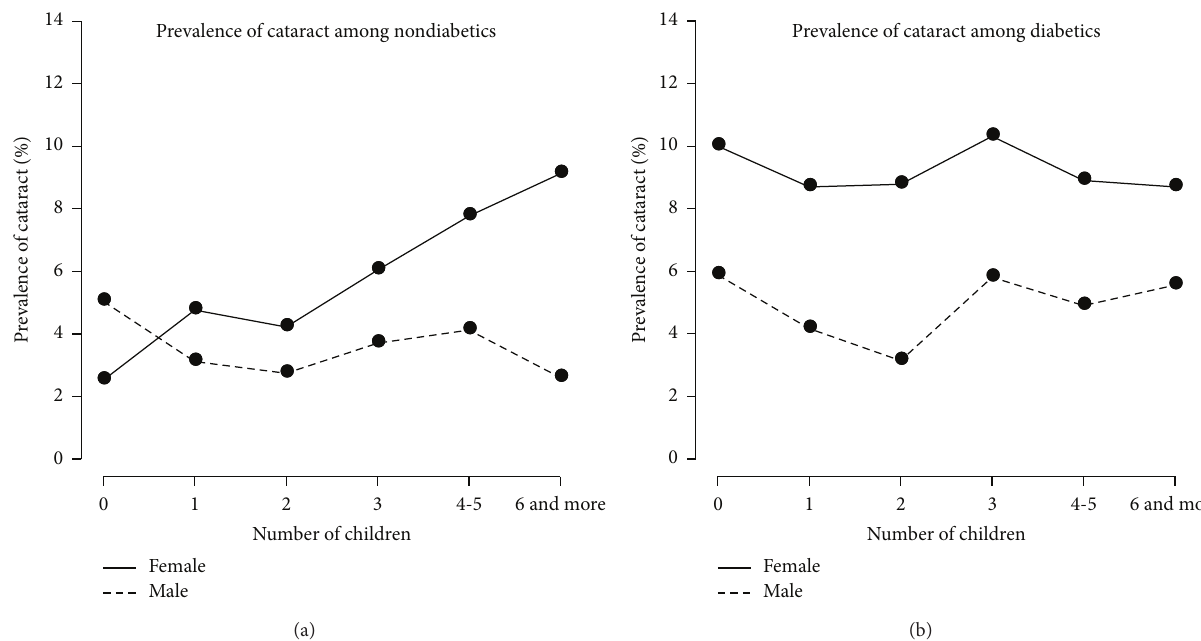
Figure 2: Line charts of the prevalence of cataract under the six levels of number of children, stratified by gender and diabetes status. The left panel was the prevalence of cataract among the 12,749 nondiabetic participants while the right one was among 1,370 diabetic participants.